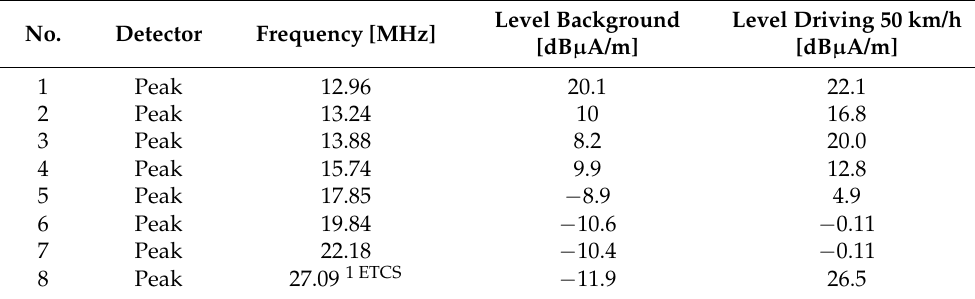
Table 4. Measurement method and results obtained for individual frequencies, for a rail vehicle travelling at a speed of 50 km/h and the electromagnetic background.